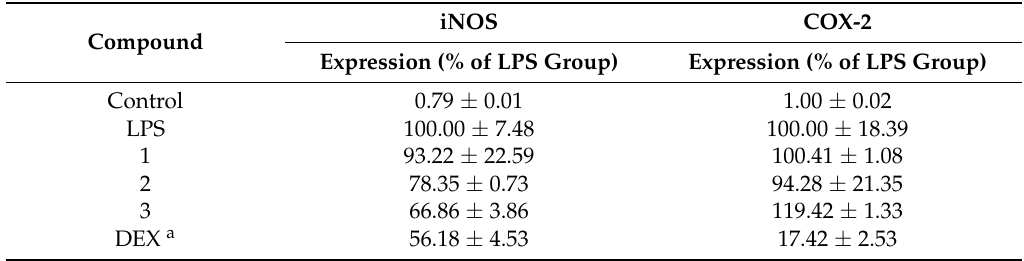
Table 5. Effects of briaranes 1 – 3 on LPS-induced iNOS and COX-2 protein expression in